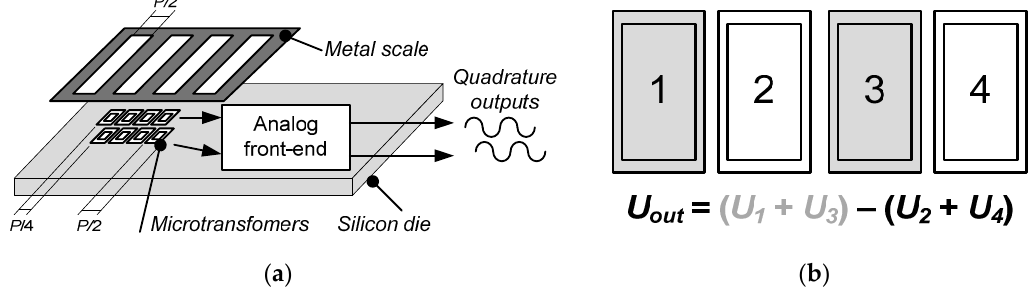
Figure 2. ( a ) A block representation of the presented microsystem with a metal scale of period and quadrature output signals; ( b ) The summation scheme of the presented microsystem comprising four microcoils per channel.